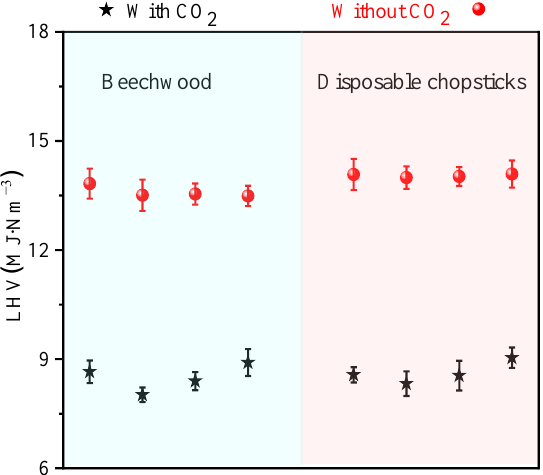
Figure 9. Effects of Ca(NO 3 ) 2 /CaCO 3 /Ca(OH) 2 on LHVs of small molecule gas: with/without CO 2 .